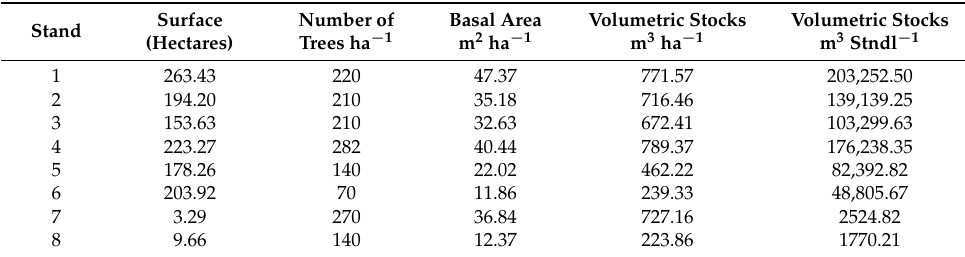
Table 2. Volume in m 3 per stand.